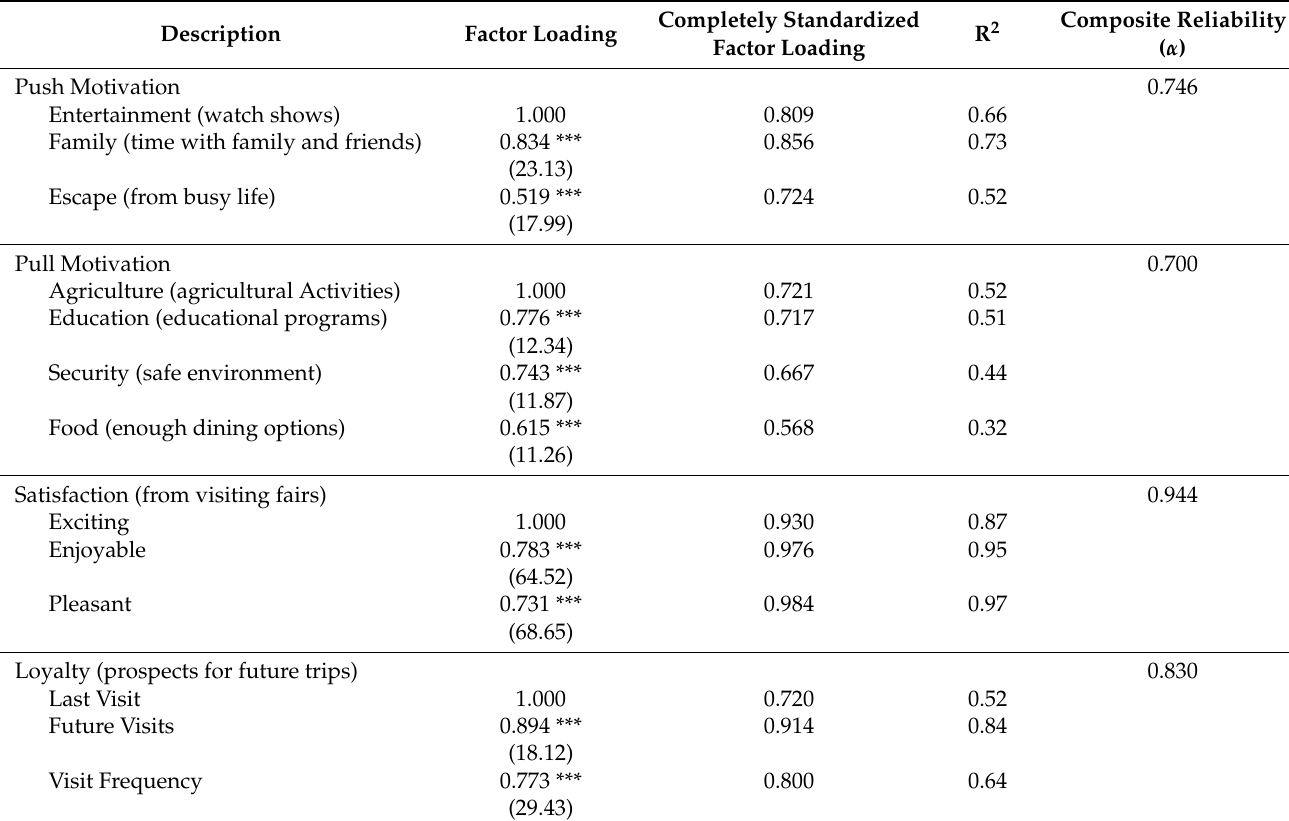
Table 4. Overall measurement model parameters and construct reliability (Cronbach alpha).